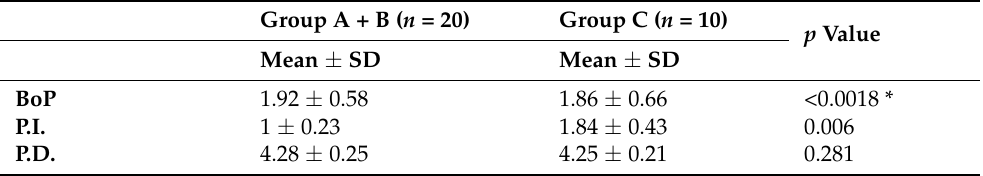
Table 1. Periodontal and microbial parameters among the A + B groups and C group before treatment.